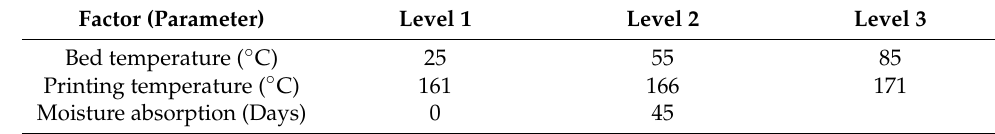
Moisture absorption